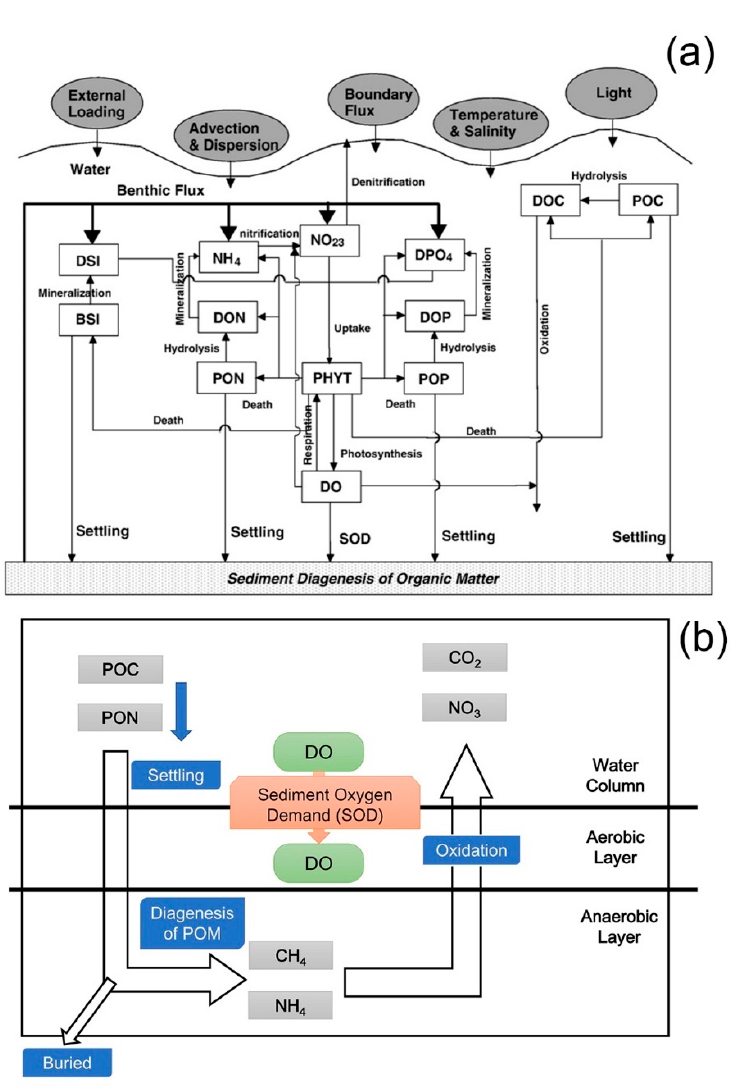
Figure 2. Schematic diagram of the ( a ) water quality model (revised from Wang et al. [33]) and ( b ) sediment flux model (revised from DiToro [40]).